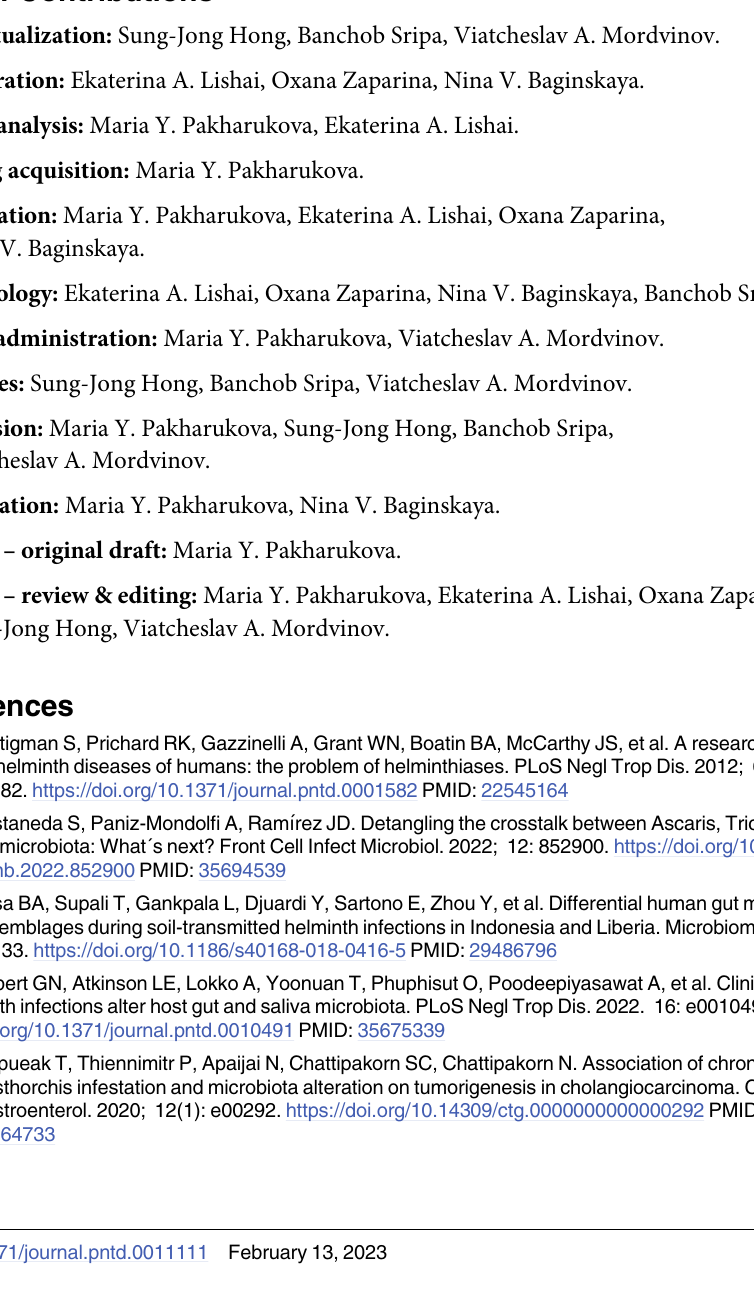
Table P in S1 Tables. The list of unique species for worms only, not identified in any other samples. Table Q in S1 Tables. Features differentially presented in OV worm microbiomes ver- sus CS worm microbiomes. Table R in S1 Tables. Features differentially presented in CS worm microbiomes versus OF worm microbiomes. Table S in S1 Tables. Differentially represented taxa among worm samples. Table T in S1 Tables. Features differentially presented in OV worm microbiomes versus OF worm